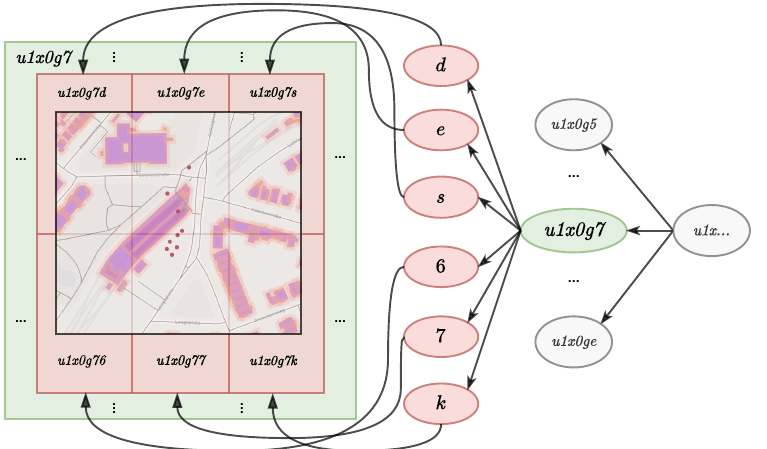
Figure 4. The encoding of the geographic simulation environment (green) into hierarchically struc- tured cells (red) with mapping into a spatial index as individual